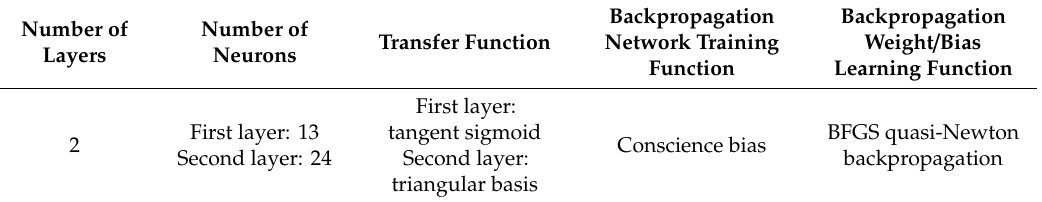
Table 5. Optimal values of ANN parameters determined by harmony search (HS)